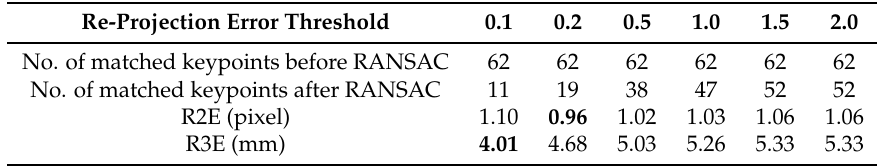
Relative 2D error (R2E) and Relative 3D error (R3E) of estimated poses with respect to the increasing re-projection threshold in RANSAC-based keypoints refinement method. dist _ thresh / min _ dist is set to 2.0. The minimum errors of R2E and R3E are in bold